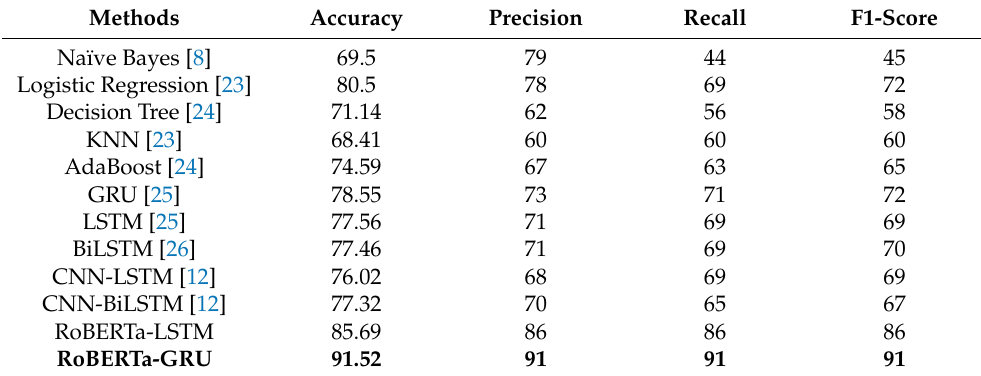
Table 9. The comparison results on the Twitter US Airline